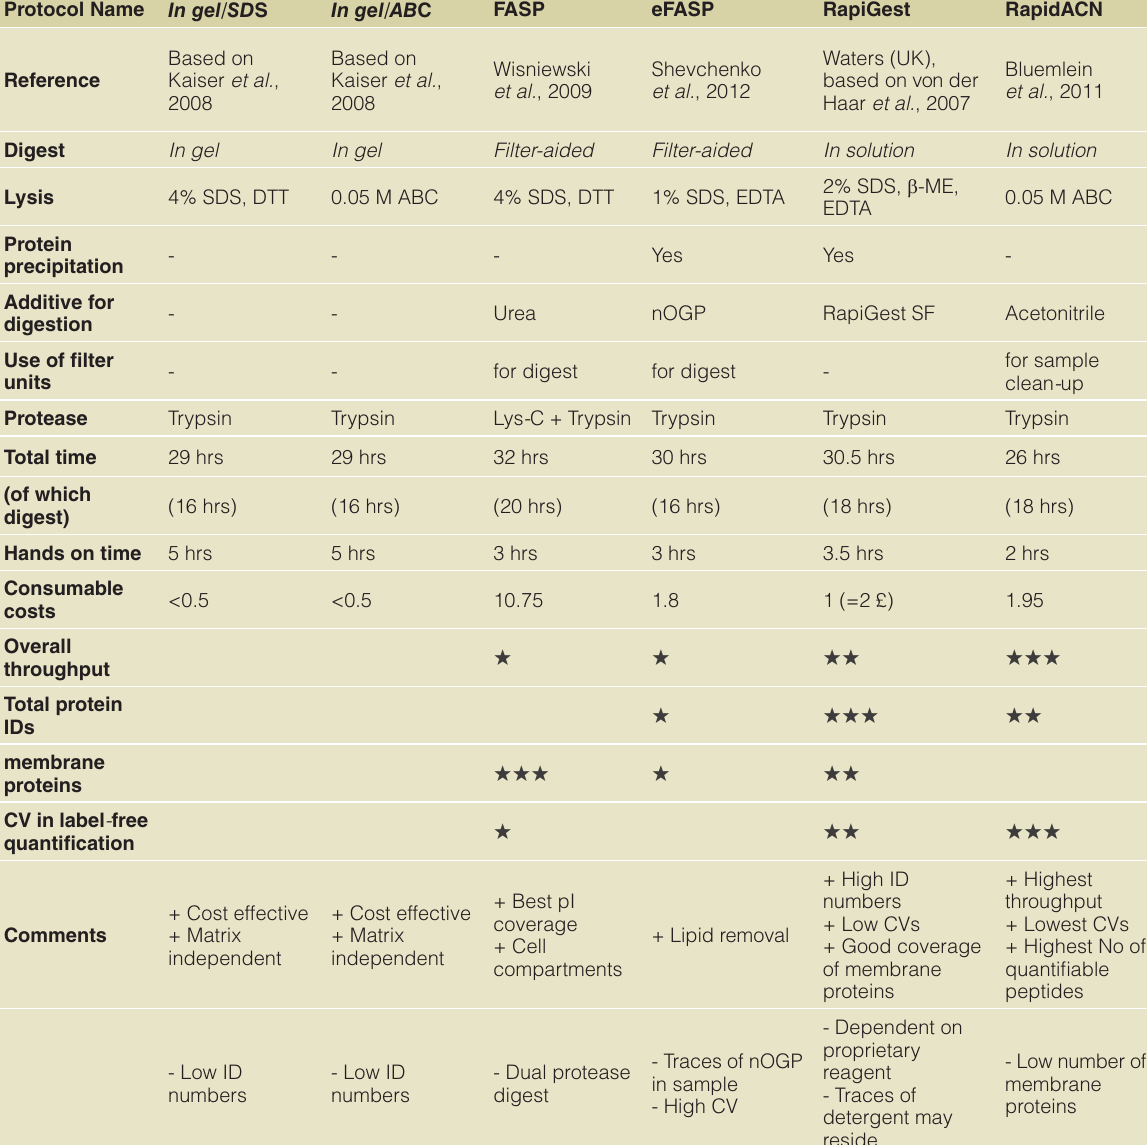
Table 1. Sample preparation methods and their performance. Summary of the main characteristics of the sample preparation methods investigated. Protocol Name In gel/SD